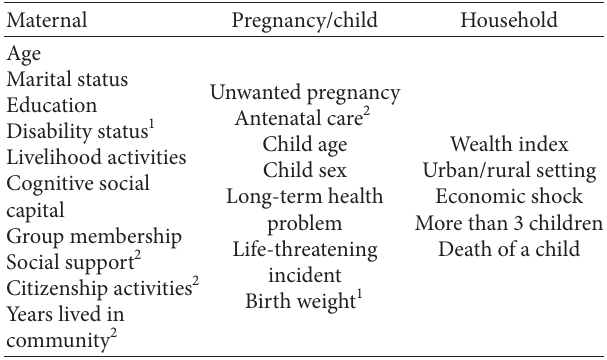
Table 1: Potential maternal distress correlates considered in analy- sis.